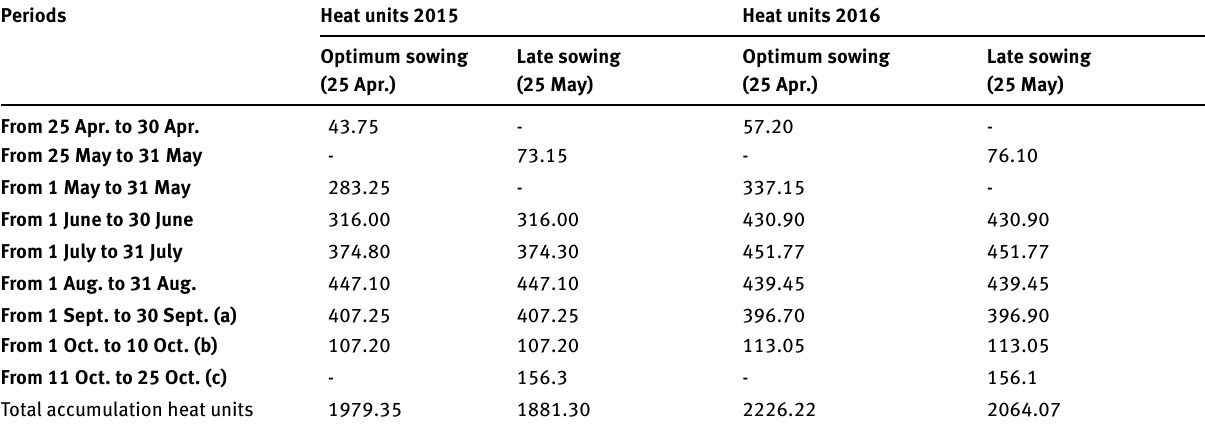
Table 3: Mean of 30 days’ periods of heat units for Sakha district in 2015 and 2016 growing season. Periods